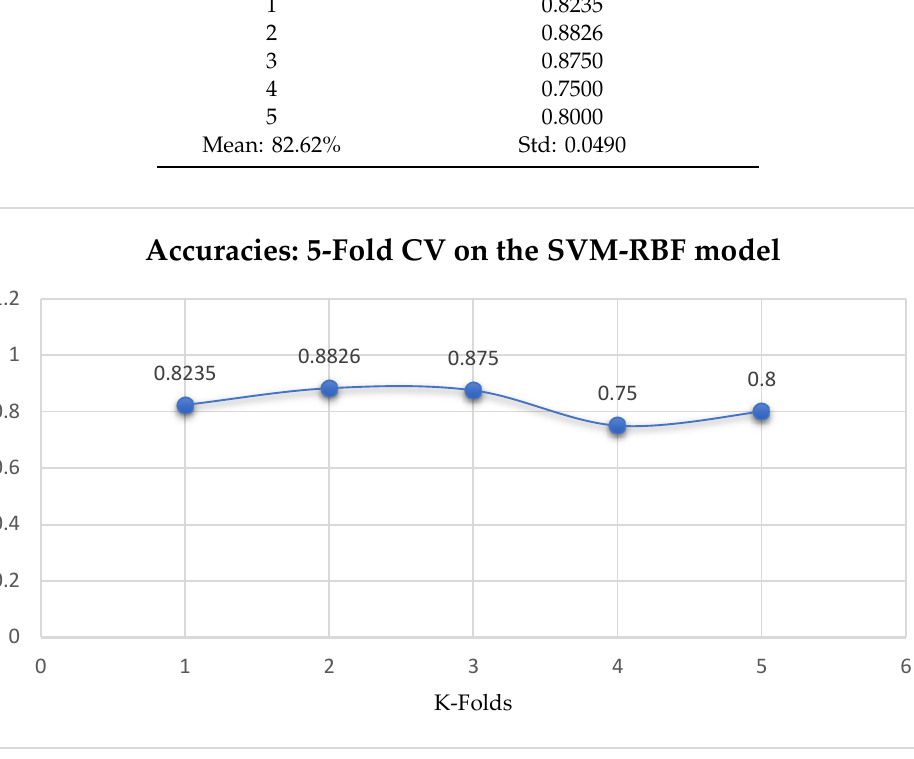
Figure 25. The accuracies achieved by the Folds after performing 5-Fold Cross-Validation on the SVM-Radial Basis Function (RBF) model.